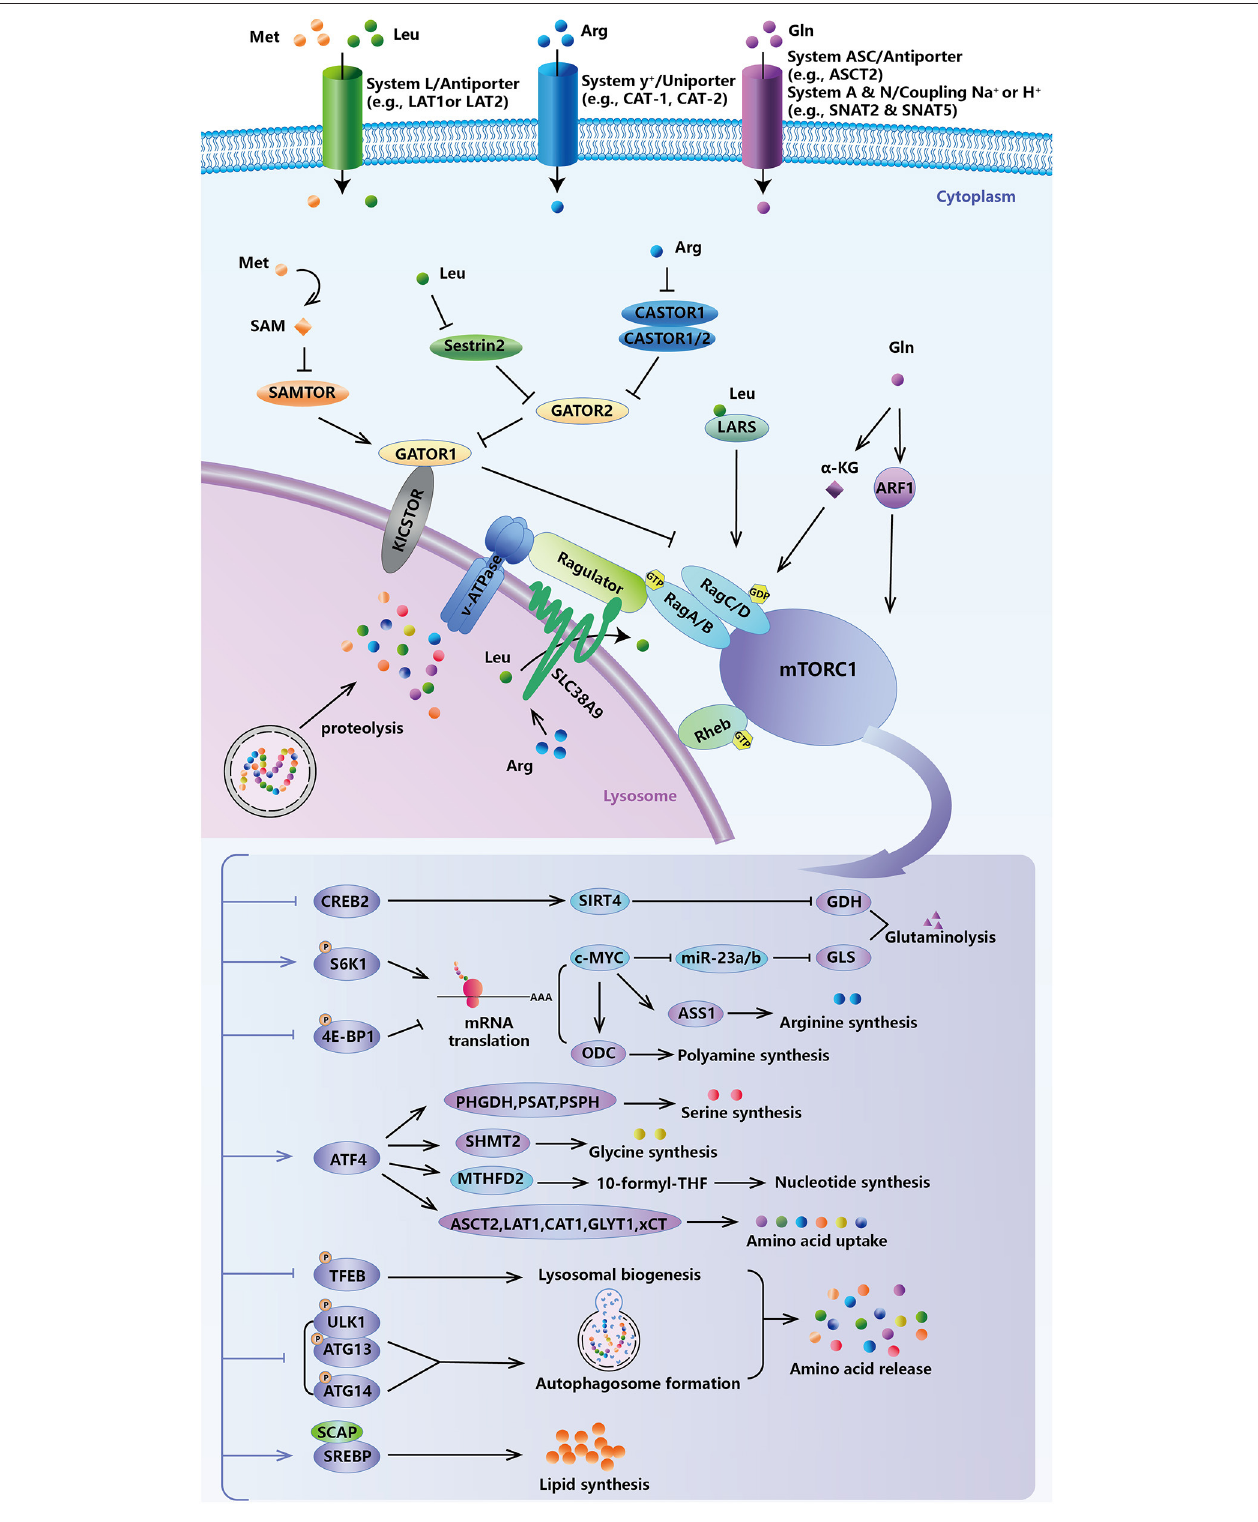
FIGURE 2 | Feedback of amino acid-sensing mTORC1 signal. mTORC1 governs cancer cells to sense fluctuations in extracellular and intracellular amino acids, and to in turn modulate intracellular levels of amino acids, lipids, and nucleotides for survival and growth demand.